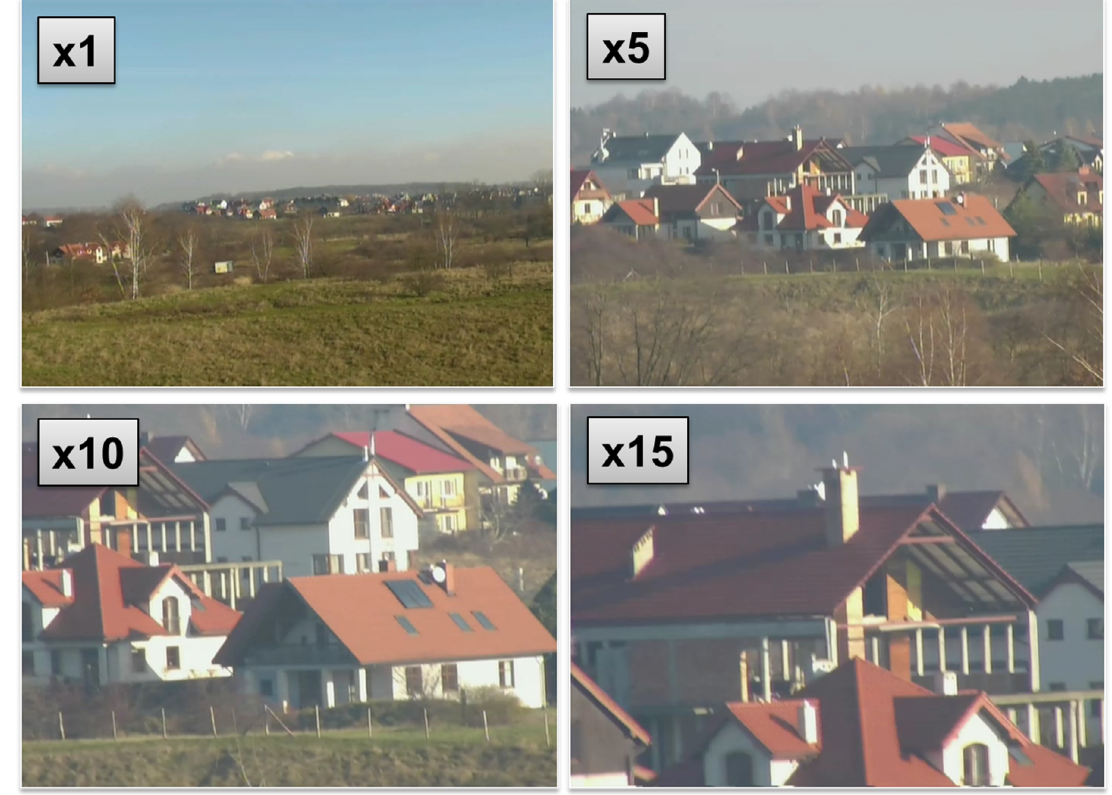
Figure 6. Real-time video stream from a daylight camera with a 15x optical zoom.